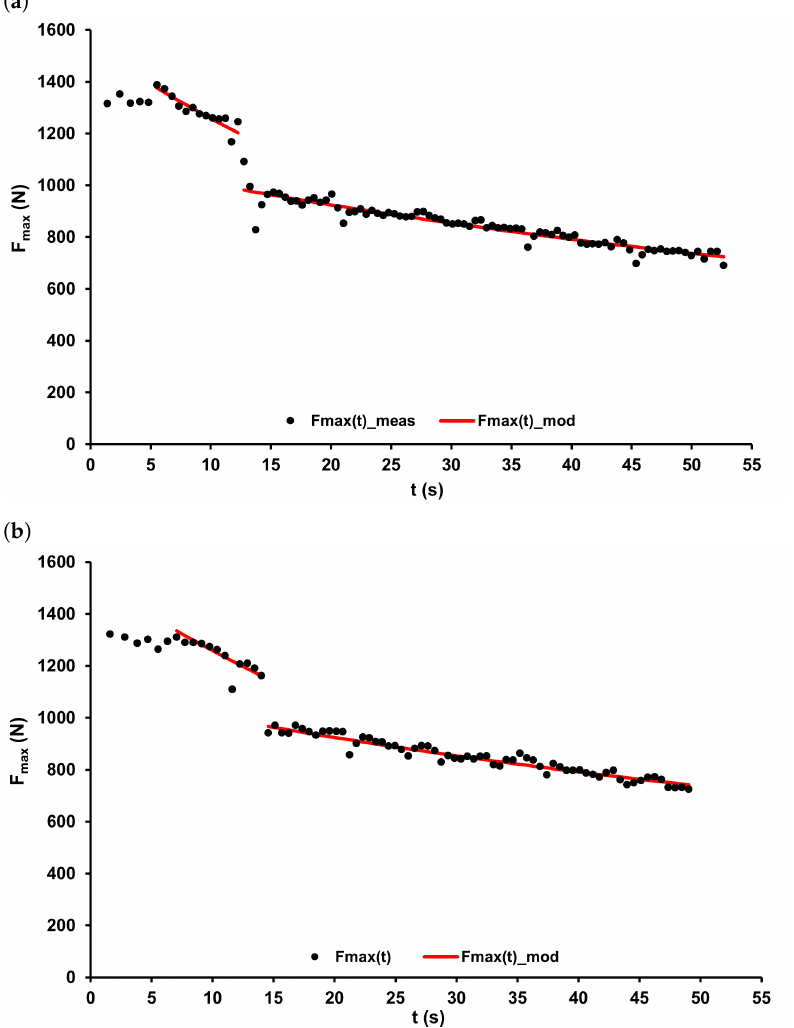
Figure 3. Time-dependent maximal mean pedal force F max with model function (prediction) calcu- lated by Equation (5) for ( a ) the first and ( b ) the second run. The physiological model parameters were fitted to the data of the first